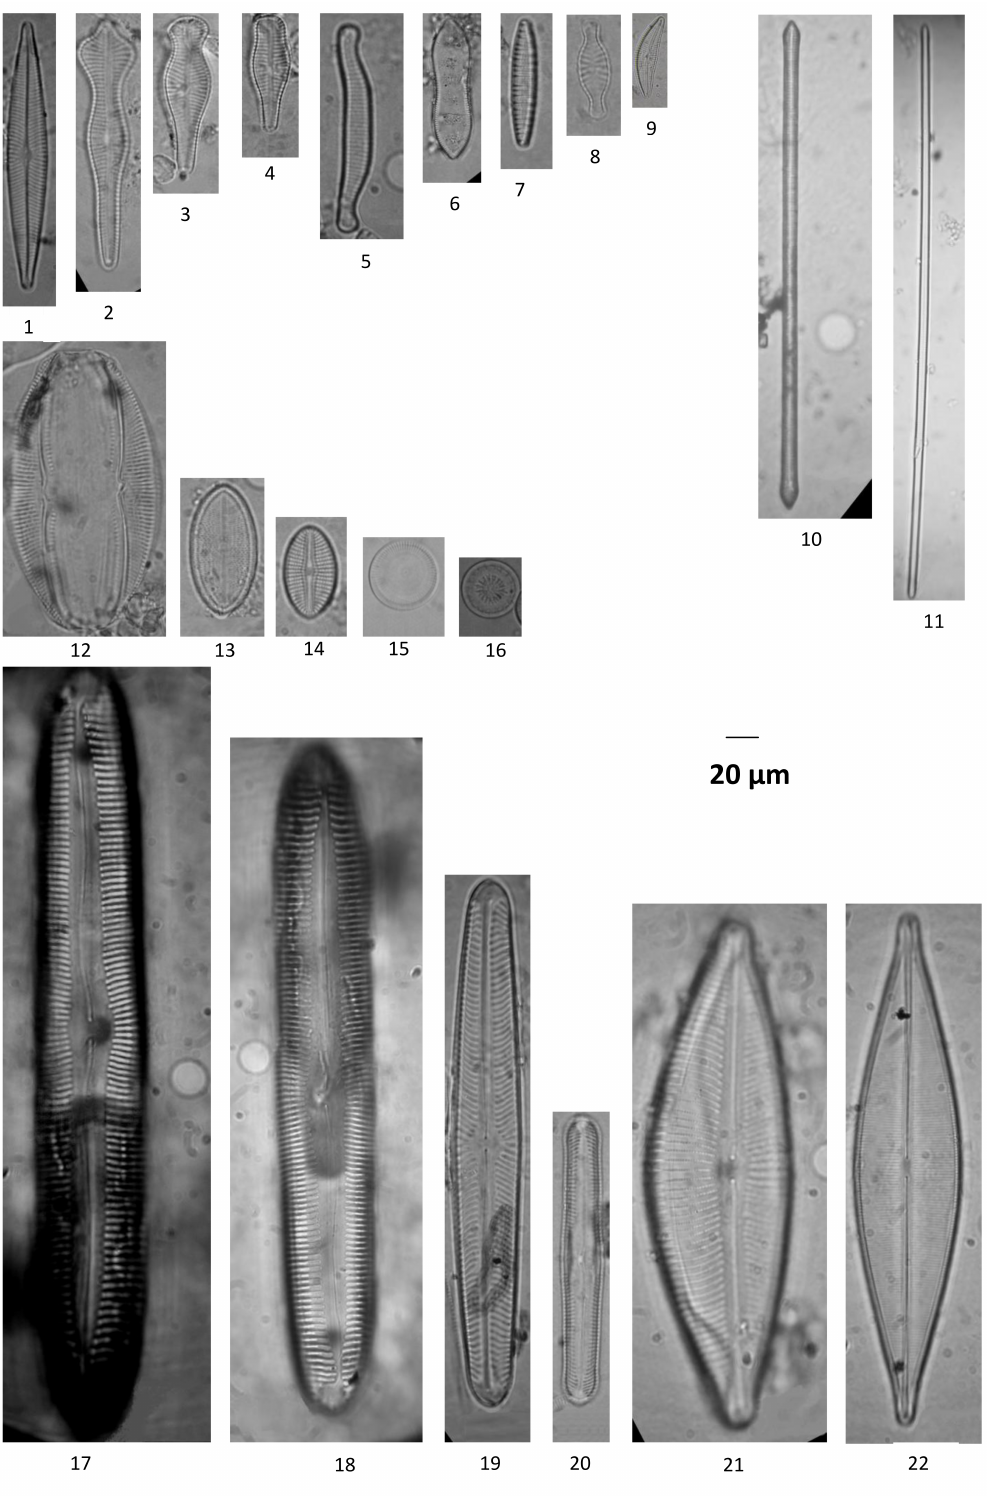
Figure 7: Diatoms in the industrial water biotopes: Navicula angusta (1), Gomphonema acuminatum (2), Gomphonema capitatum (3), Gomphonema pala (4), Eunotia arcubus (5), Cymatopleura solea (6), Nitzschia denticula (7), Planothidium daui (8), Cymbopleura ineaqualis (9), Ulnaria biceps (10), Flagilaria capitata (11), Amphora copulata (12), Cocconeis placentula (13), Cocconeis sp. (14), Ellerbackia arenaria (15), Cyclotella radiosa (16), Pinnularia viridis (17), Pinnularia nobilis (18) , Pinnularia divergens (19), Pinnularia gibba (20), Cymbopleura inaequalis (21), Craticula cuspidata (22). All LM micrographs, scale bars = 20